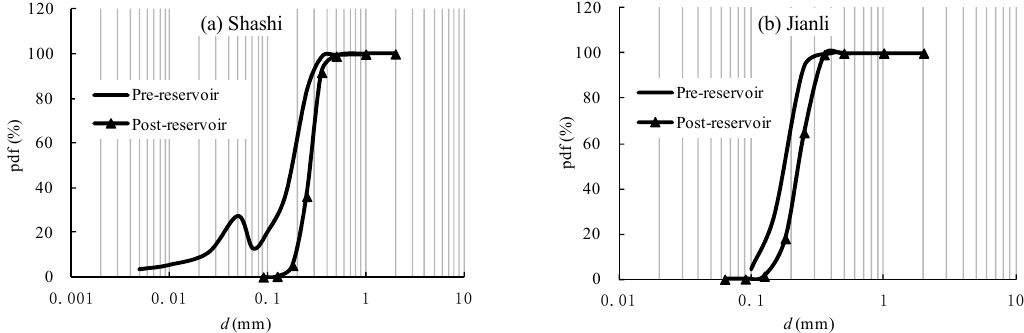
Figure 13. Bed load of Shashi ( a ) and Jianli ( b ) hydrological stations. Data in ( a ) were measured 9 July 1986 at Xinchang hydrological station, and 6 June 2013 at Shashi hydrological station; data in ( b ) were measured 26 May 1986 and 13 March 2013 at Jianli hydrological station.